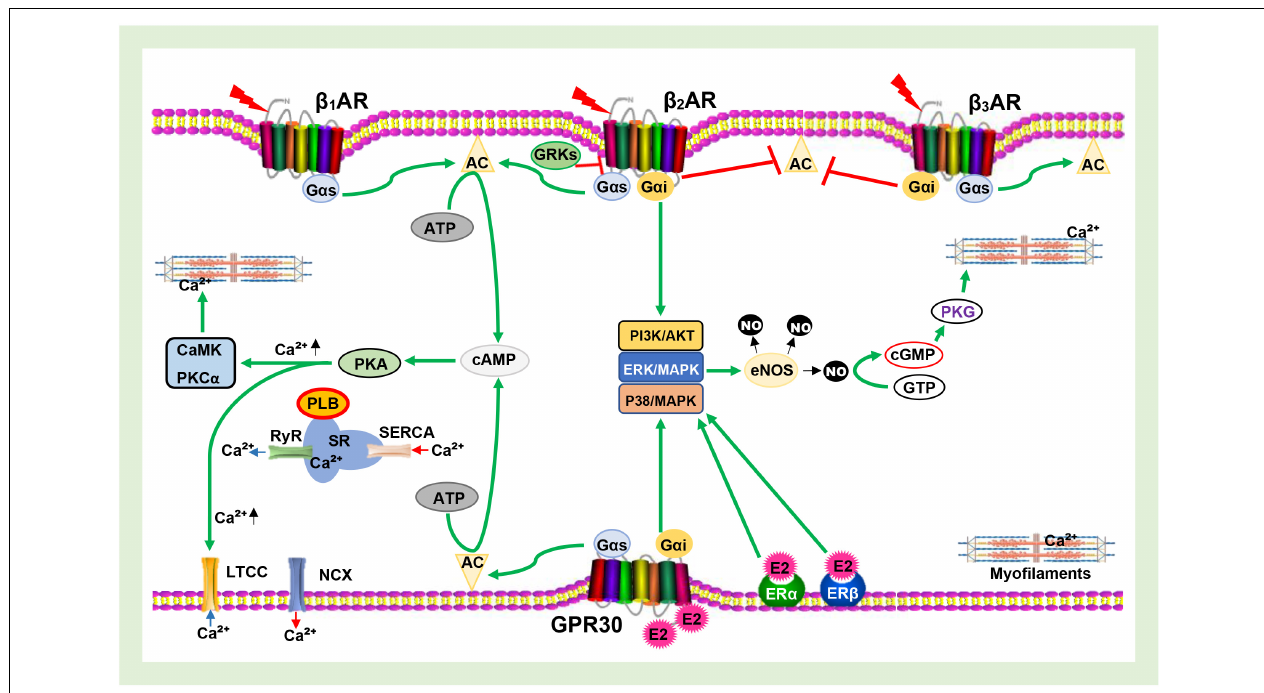
FIGURE 2 | Schematics of Calcium channel cascades and Myofilament activation being facilitated by β -adrenergic receptors ( β ARs) and Estrogen receptors (ERs signaling. AC, Adenylyl cyclase; cAMP, Cyclic adenosine monophosphate; PKA, Protein kinase A; PKC α , Protein kinase C alpha; GRKs, G protein-coupled receptor kinases; E2, Estrogen; eNOS, Endothelial nitric oxide synthase; NO, Nitric oxide; PDE, Phosphodiesterase; SR, Sarcoplasmic reticulum; PLB, Phospholamban; RyR, Ryanodine receptor; SERCA, Sarcoplasmic reticulum Ca 2 + ATPase; LTCC, L-type calcium channel; NCX, Sodium-calcium exchanger; CaMK, Calmodulin- dependent kinase; cGMP, Cyclic guanosine monophosphate; GTP, Guanosine triphosphate; PKG, Protein kinase G; , Phosphorylated; , Inhibit; , Upregulate; , Ca 2 + entry/release; , Ca 2 + uptake/expulsion; ,